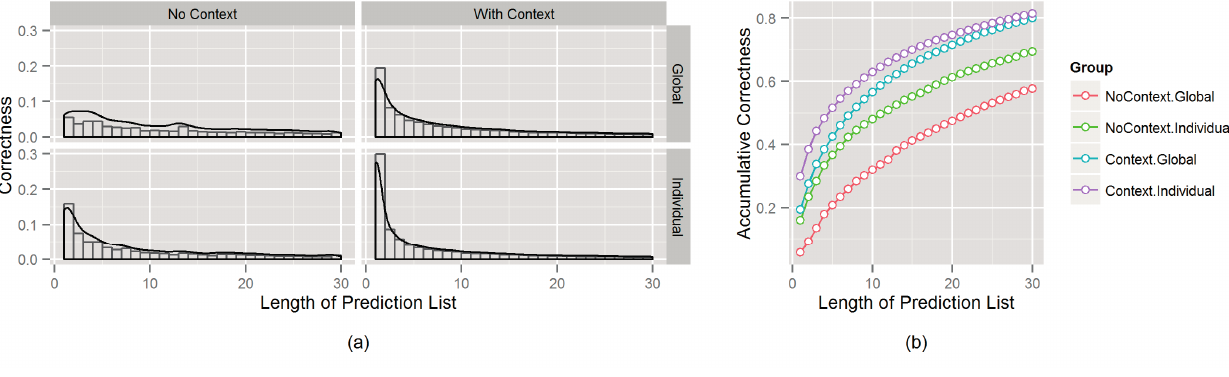
Figure 4. Comparisons of prediction correctness between the groups in independent ( a ) and accumulative ( b )